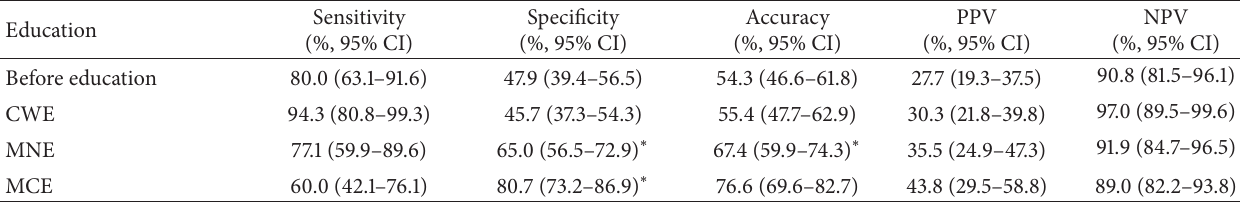
Table 2: Estimation of deep submucosal invasion of colorectal tumors by